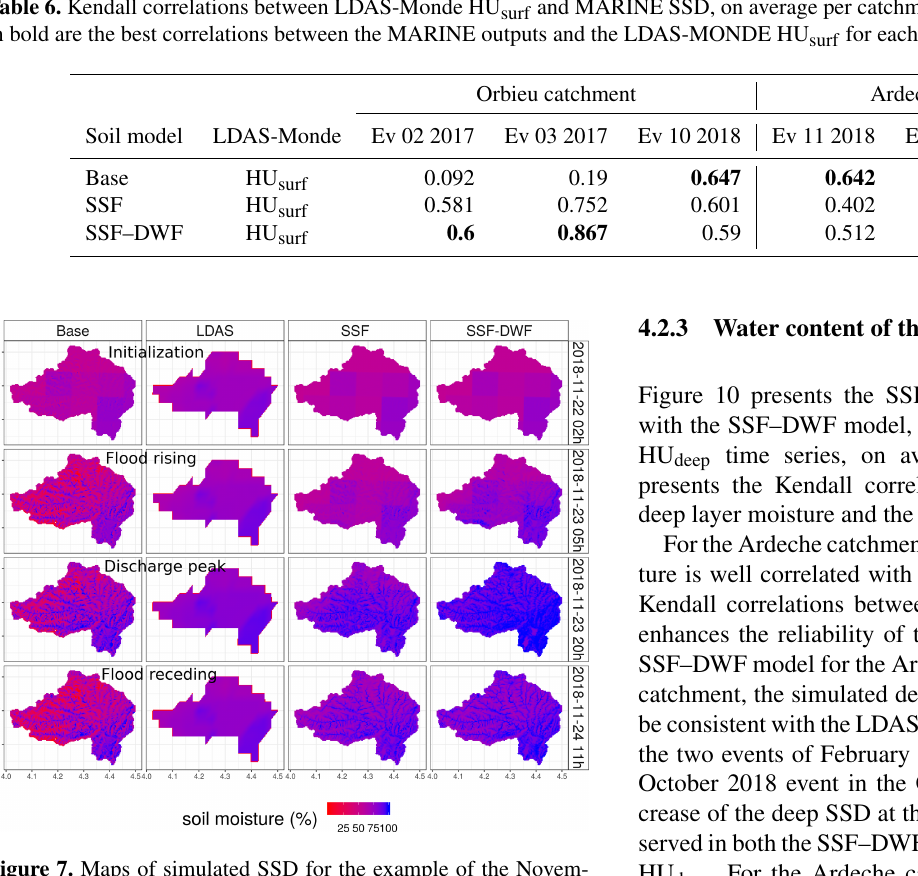
Figure 7. Maps of simulated SSD for the example of the Novem- ber 2018 event in the Ardeche catchment. MARINE simulation out- put with the base, SSF, and SSF–DWF models are presented as well as the LDAS-Monde HU surf maps. Four time steps of the simulation are considered: the first time step of the run, one time step during the flow rise, the peak flow hour, and one time step during the flow